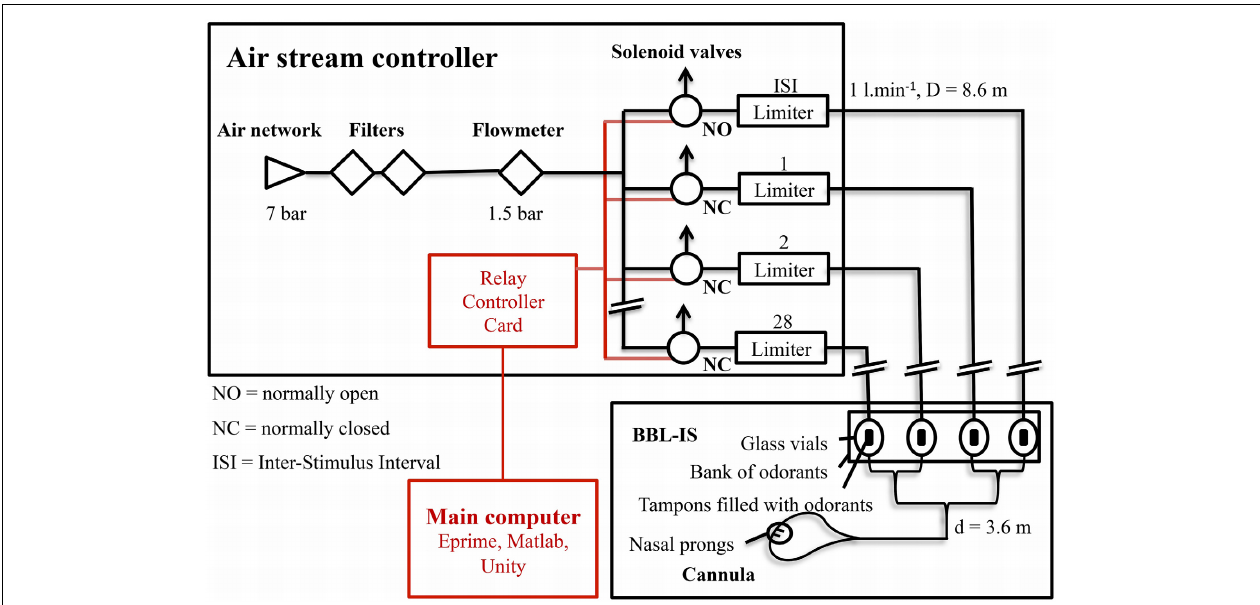
FIGURE 1 | Schematic diagram of the OD. For clarity reasons, channels 3 to 27 are not represented.